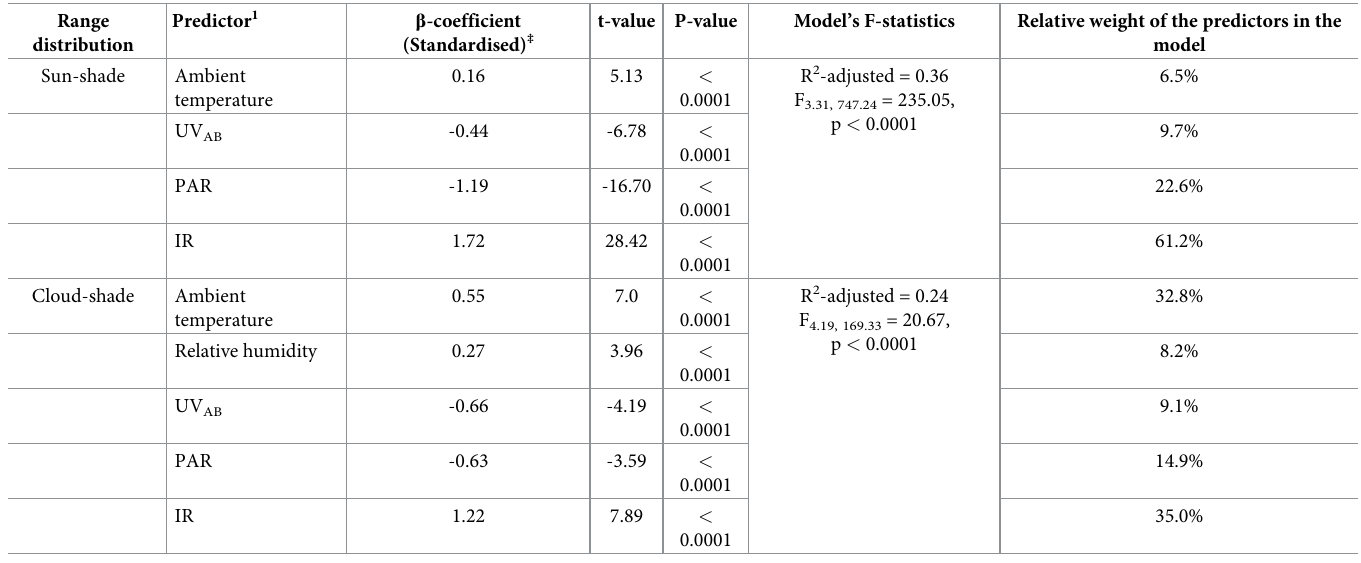
Table 9. Multiple ridge regression analyses (ridge parameter, k = 0.02) on the number of hens in the ‘sun-shade’ and ‘cloud-shade’ across the day in WA for all observation months. Only variables that significantly contributed to the most parsimonious model are presented. Range distribution